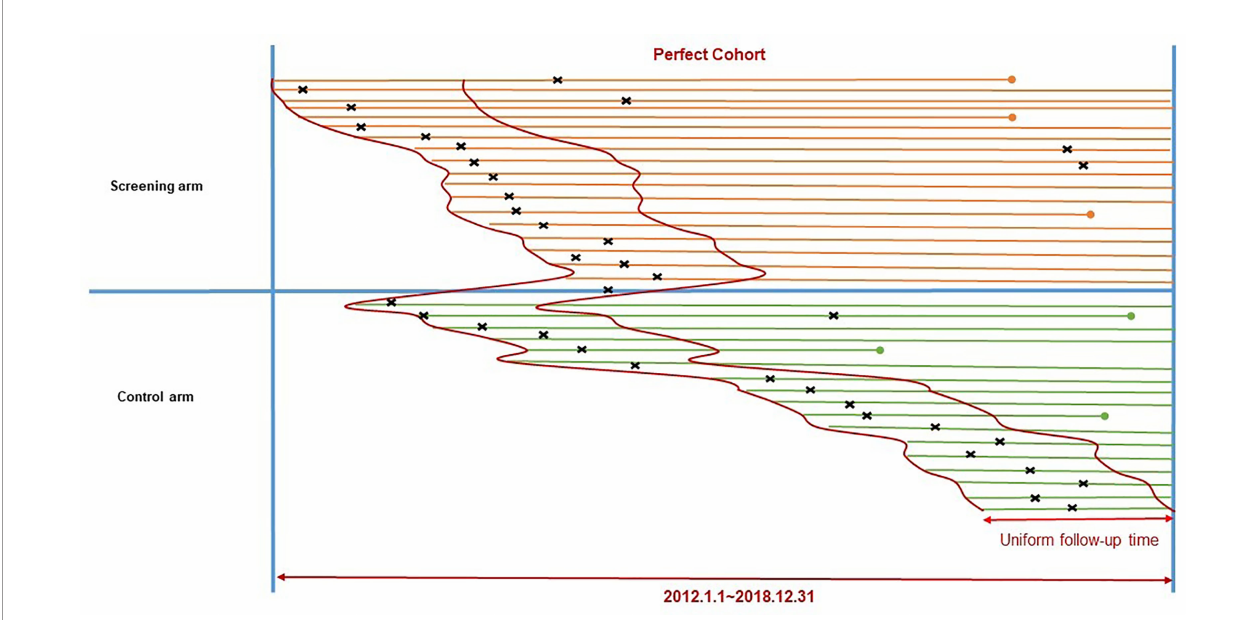
FIGURE 1 | Construction of the “ Perfect Cohort ” to include cancer cases from the ESECC trial. Segments refer to time periods of follow-up for participants in the two study arms. The left endpoint of a segment refers to the time of enrollment, and the right endpoint refers to the end of follow-up (2018.12.31) or death (a dot). × The symbol “ × ” above each segment refers to the time of diagnosis for upper GI.